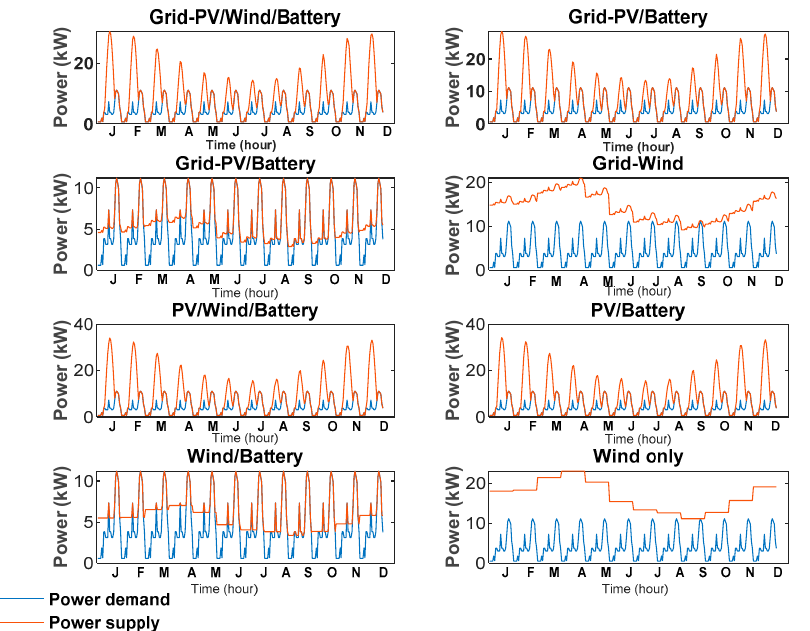
Figure 7. Comparison of the variation in the energy supply and the energy demand over one year period corresponding to 0% PSDP .